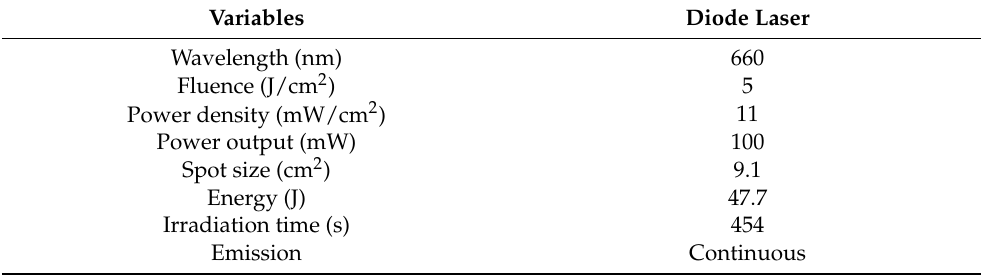
Table 1. Laser parameters.